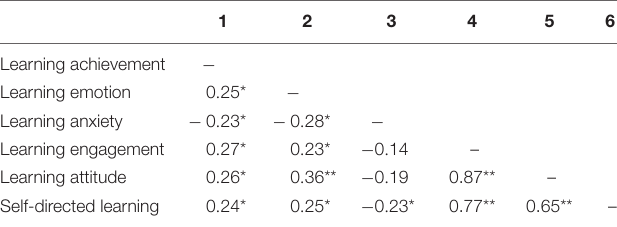
TABLE 3 | Pearson correlation analysis of different